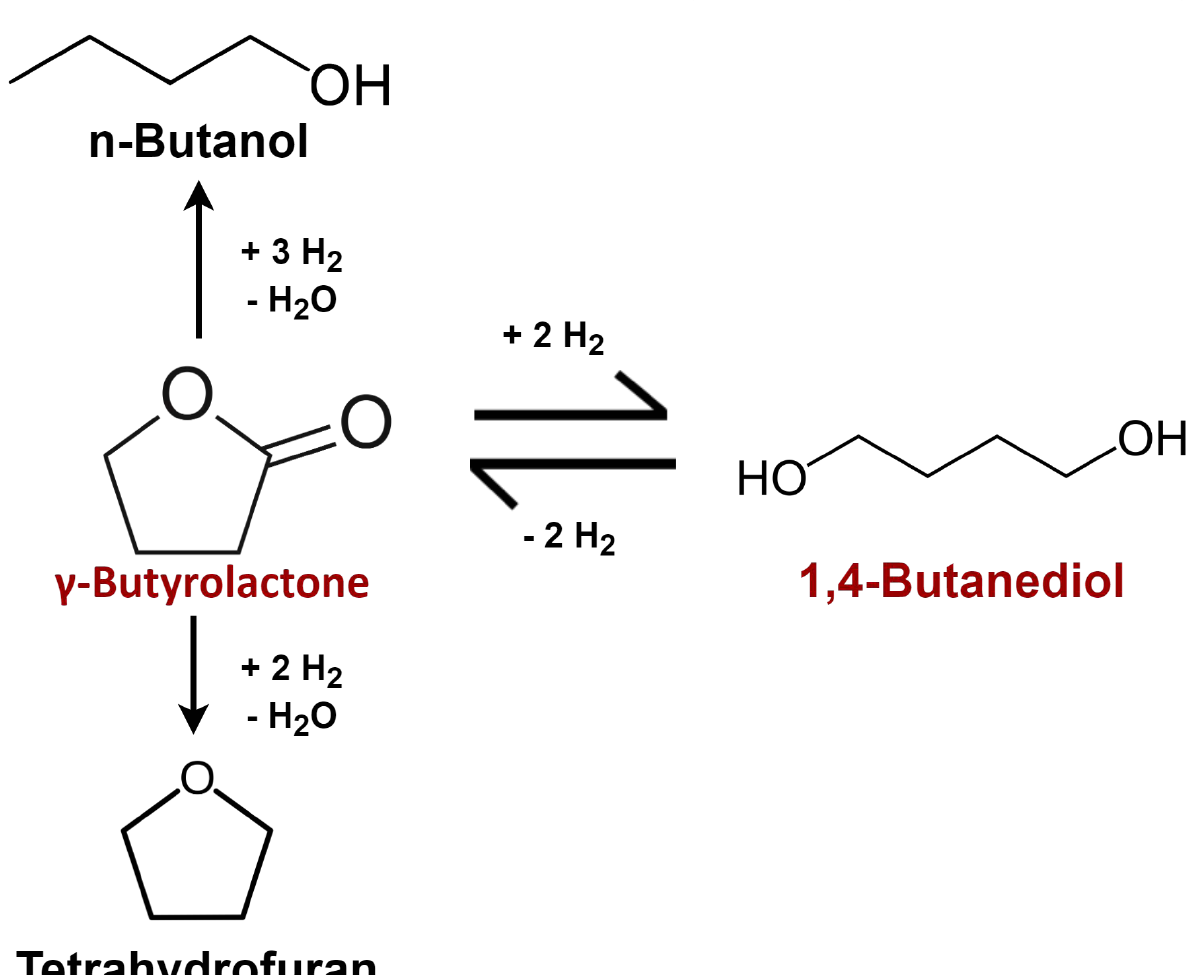
Figure 1. Reaction scheme used for the construction of the kinetic